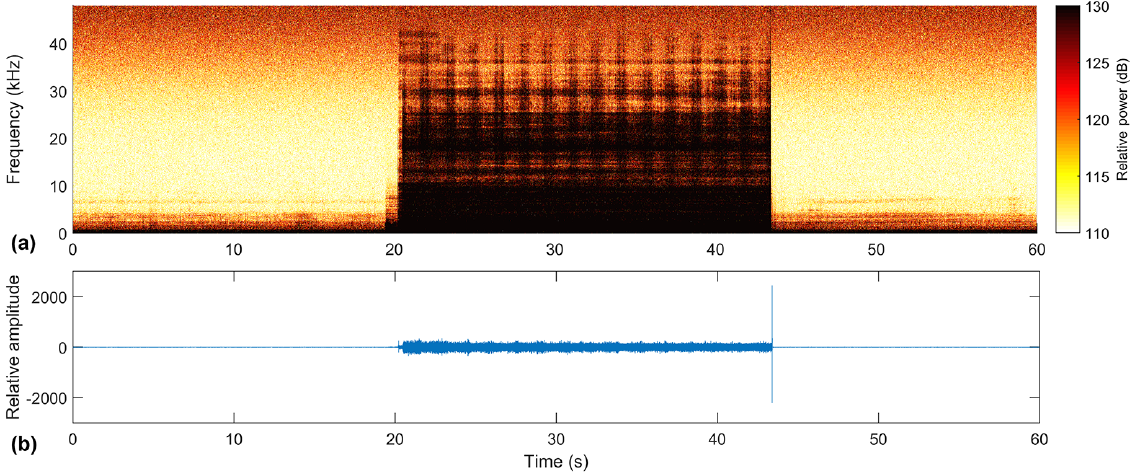
Figure 10. Spectrogram (a) and time series (b) showing an example of the noise produced by battery movement and volume piston. The volume piston noise starts just before 20s, and is then masked by the battery movement